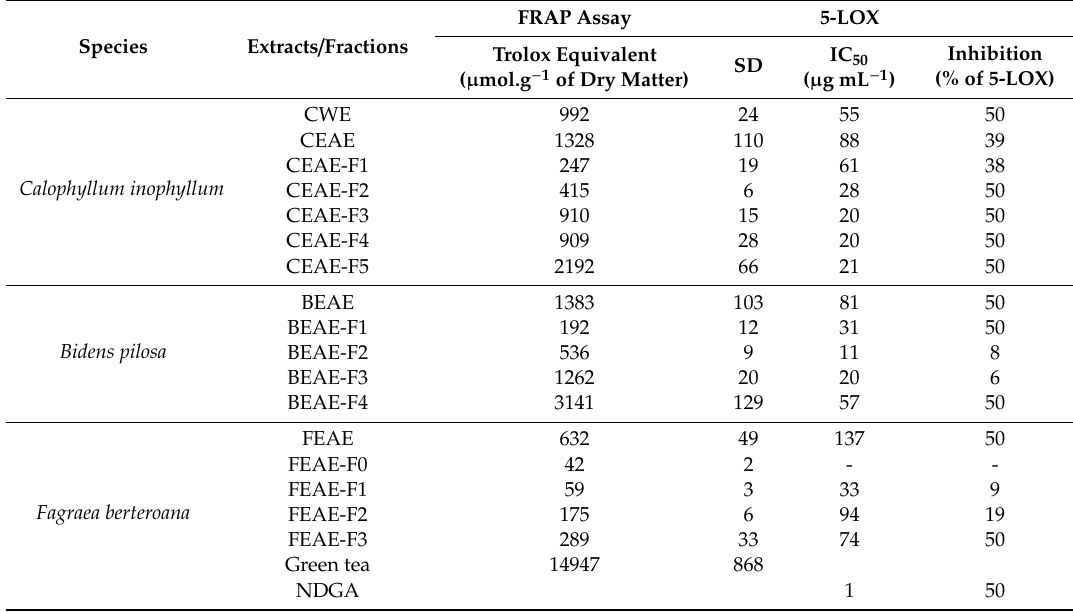
Table 2. Antioxidant potential (FRAP) and anti-inflammatory (5-LOX) activity of the extracts and fractions of the three